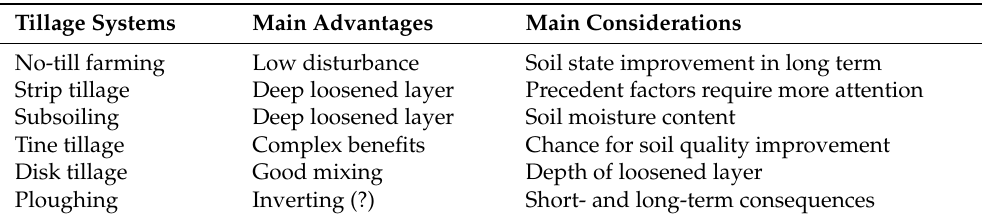
Short- and long-term